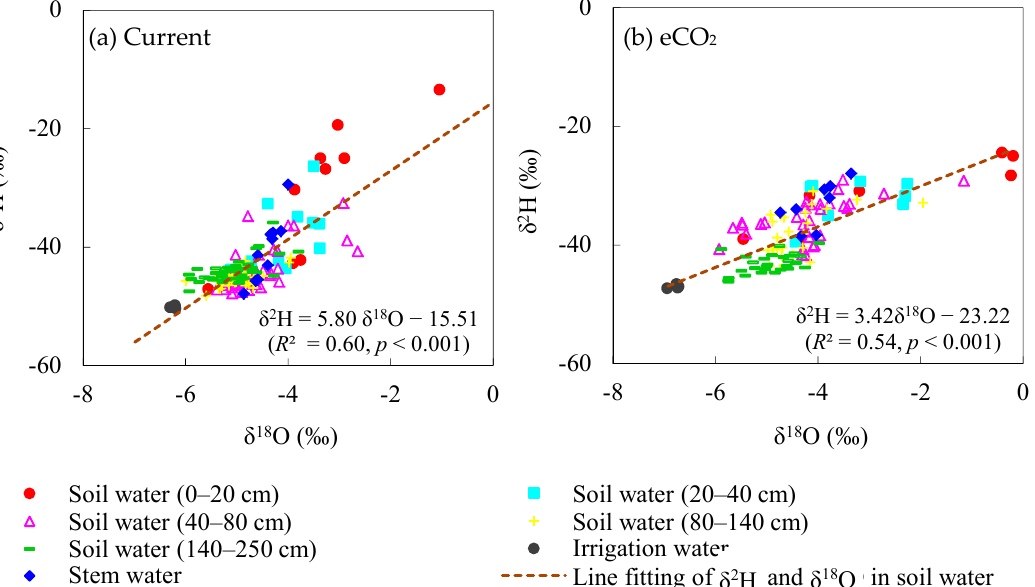
Figure 4. Isotopic values of stem water, irrigation water, and soil water in different layers under ( a ) current and ( b ) eCO 2 treatments, respectively.